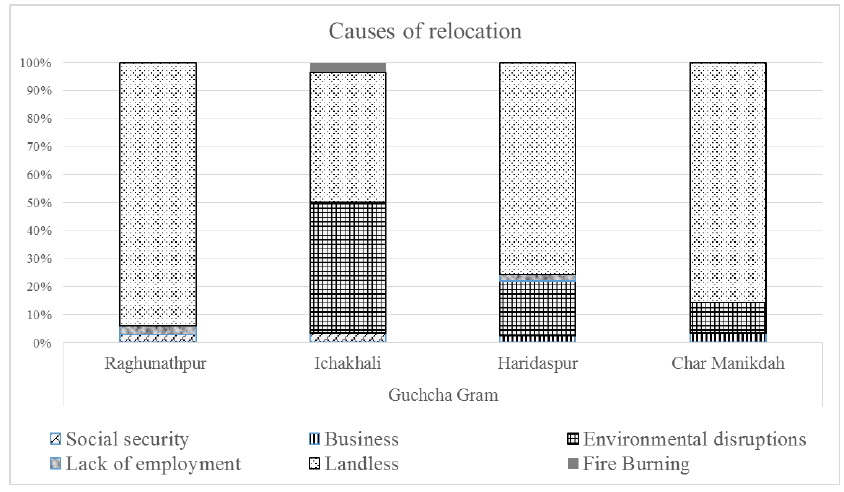
Figure 2. Causes of relocation according to GG. Source: Field survey 2014.